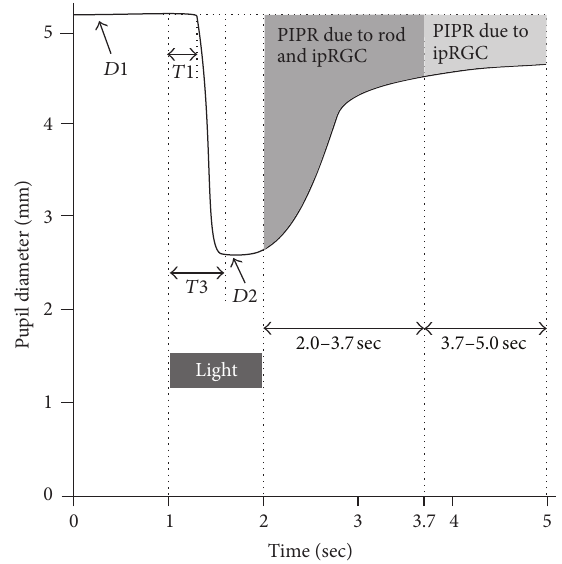
Figure 1: Pupillary light reflex waveform and kinetic